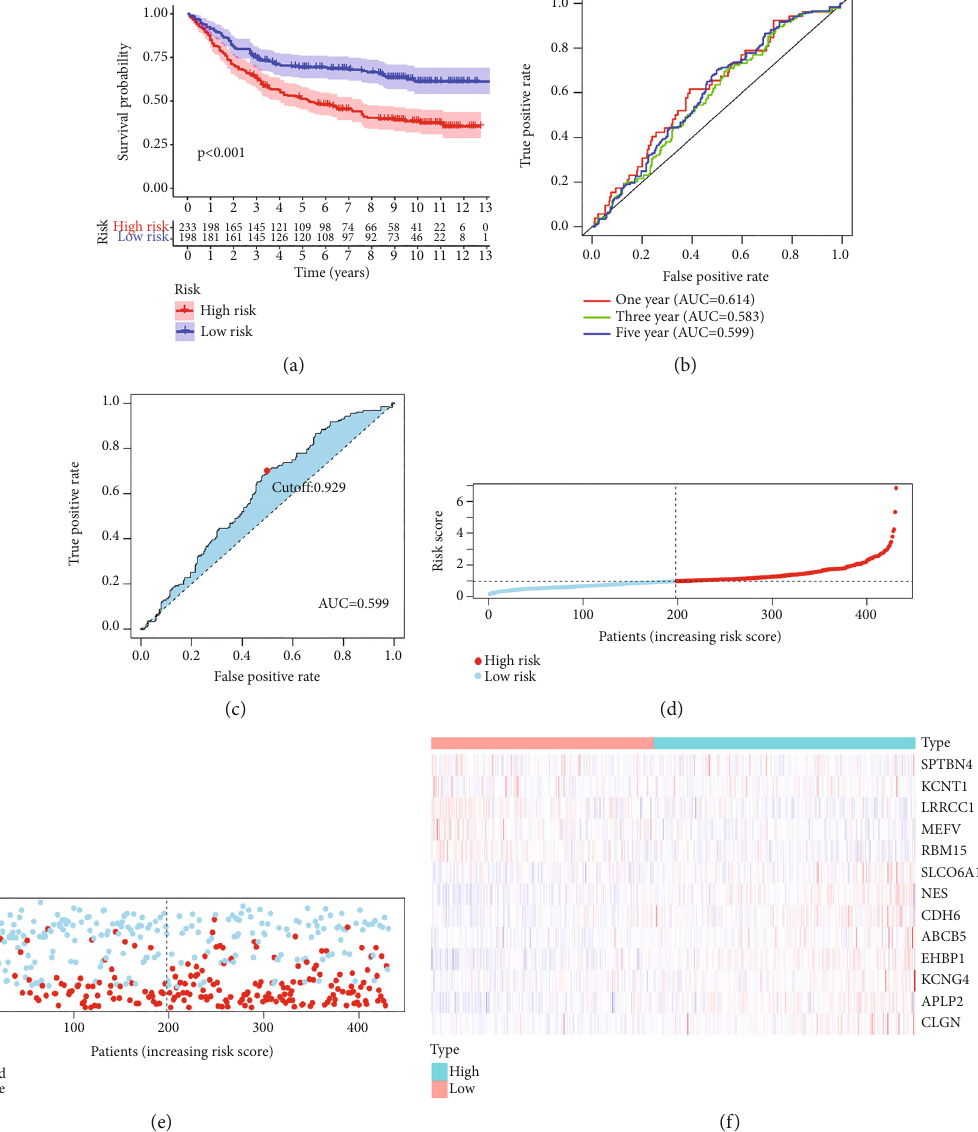
Figure 3: (a) Predictive function of the risk signature in testing set. Kaplan-Meier analysis was conducted to determine survival di ff erence between the high-risk group and the low-risk group. (b, c) Receiver operating characteristic (ROC) curve was plotted to assess the accuracy of the signature in predicting patients ’ survival outcomes. (d, e) Patients were ranked according to risk score value, and the survival status of the patients was visualized. (f) A heatmap was plotted to visualize the expression pattern di ff erence of the genes in the signature between the high-risk group and the low-risk